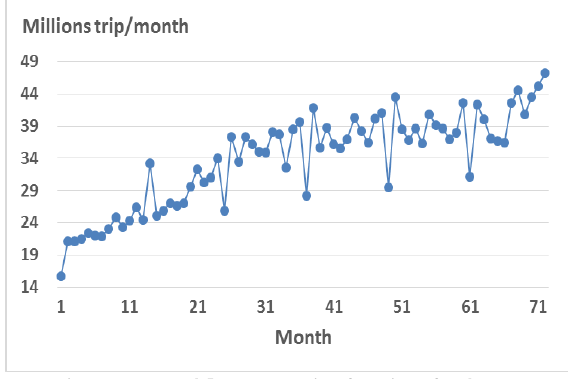
Figure 5. Monthly metro trips for city of Tehran.